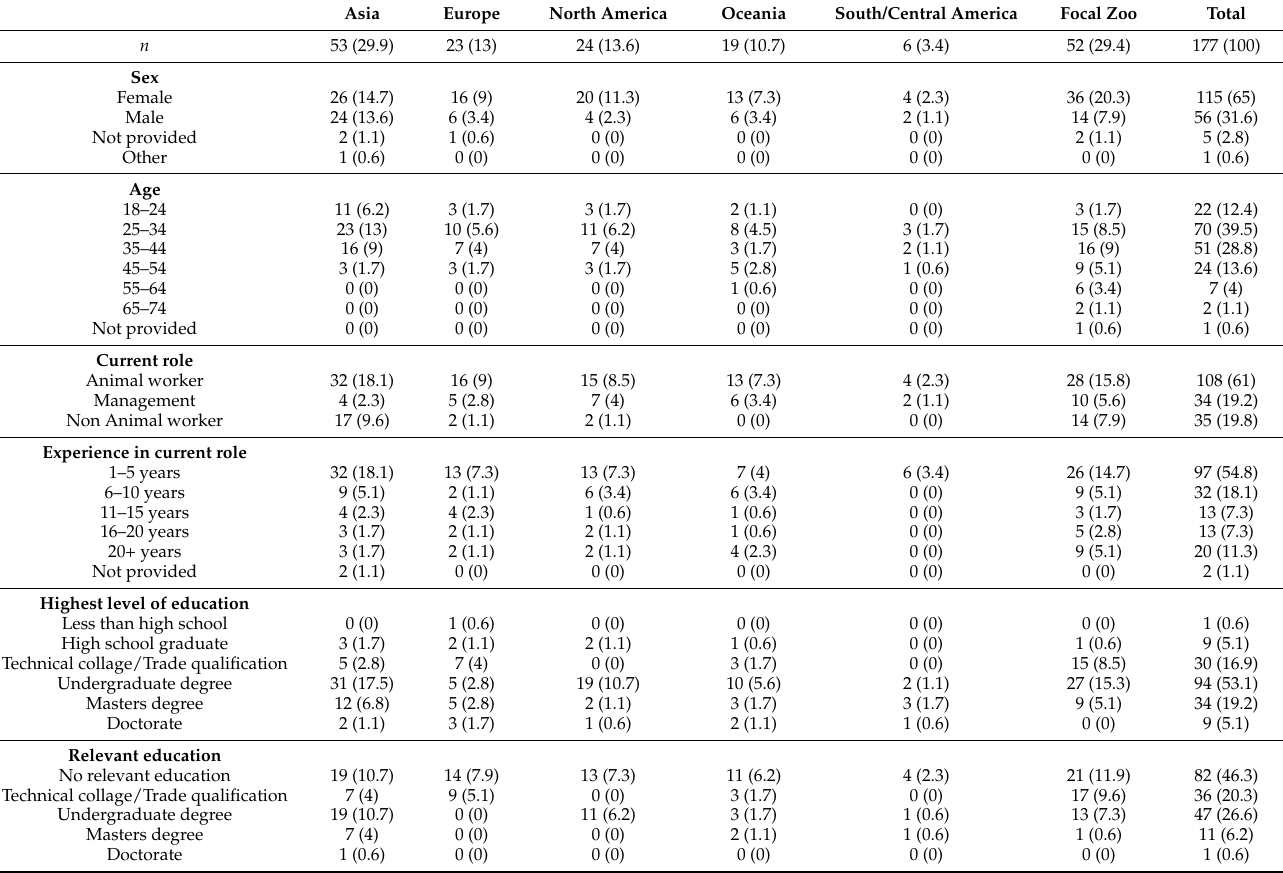
Table 2. Demographic information for respondents included in analysis. The number of respondents in each category are presented with the proportion of the total shown as a percentage in